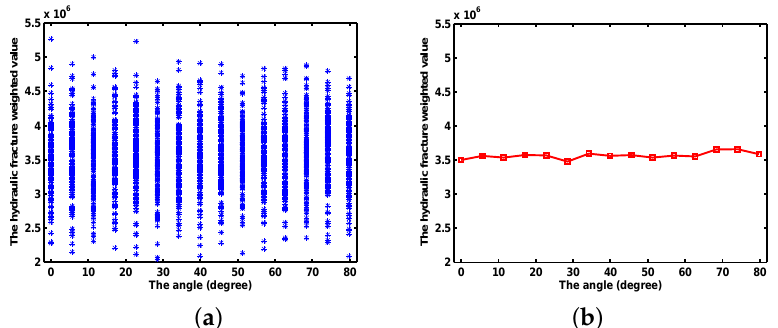
Figure 14. The influence of dip angle ( α ) on the hydraulic fracture weighted value when the angle between two groups fracture remains orthogonal. Here, n = 250 and l = 0.2 m. The realizations belong to fifteen kinds of α (0 ◦ ,6 ◦ ,11 ◦ ,17 ◦ ,22 ◦ ,28 ◦ ,34 ◦ , 40 ◦ ,46 ◦ ,52 ◦ ,57 ◦ ,63 ◦ ,69 ◦ ,74 ◦ and 80 ◦ ), with 150 groups of randomly generated fractures for each kind of α . ( a ) scatter distribution of the hydraulic fracture weighted value with different values of α ; ( b ) average of the hydraulic fracture weighted value with different values of α .